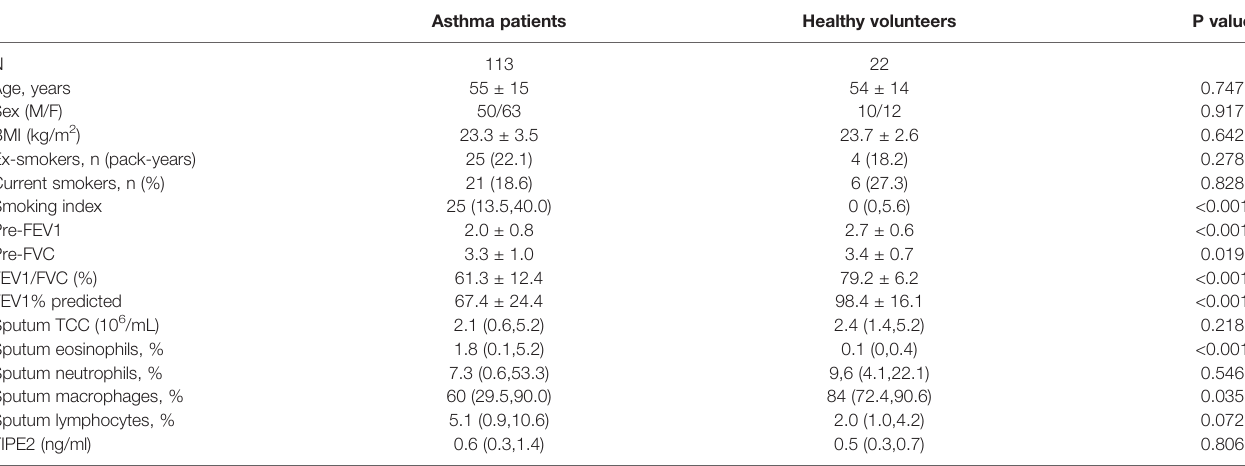
TABLE 2 | Demographic, functional, and in fl ammatory characteristics of asthma patients and healthy